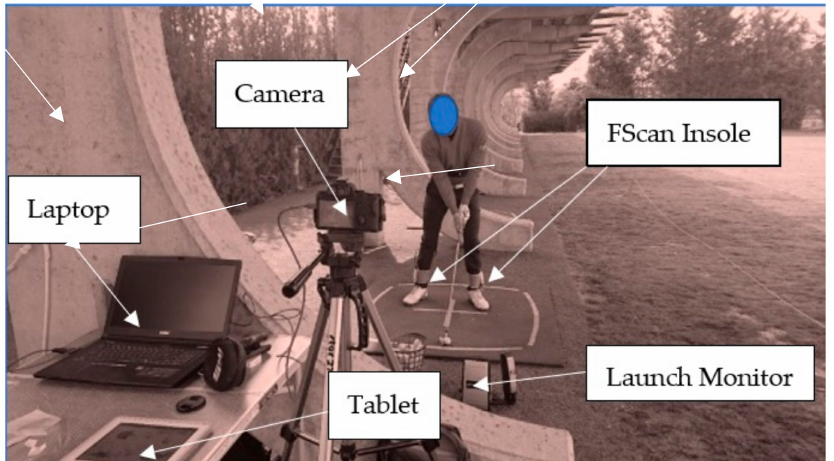
Figure 2. Data recording environment including the F-Scan insoles, the camera used to record the video sequences, the laptop and table which store the data, and the launch monitor used to assess the swing quality.